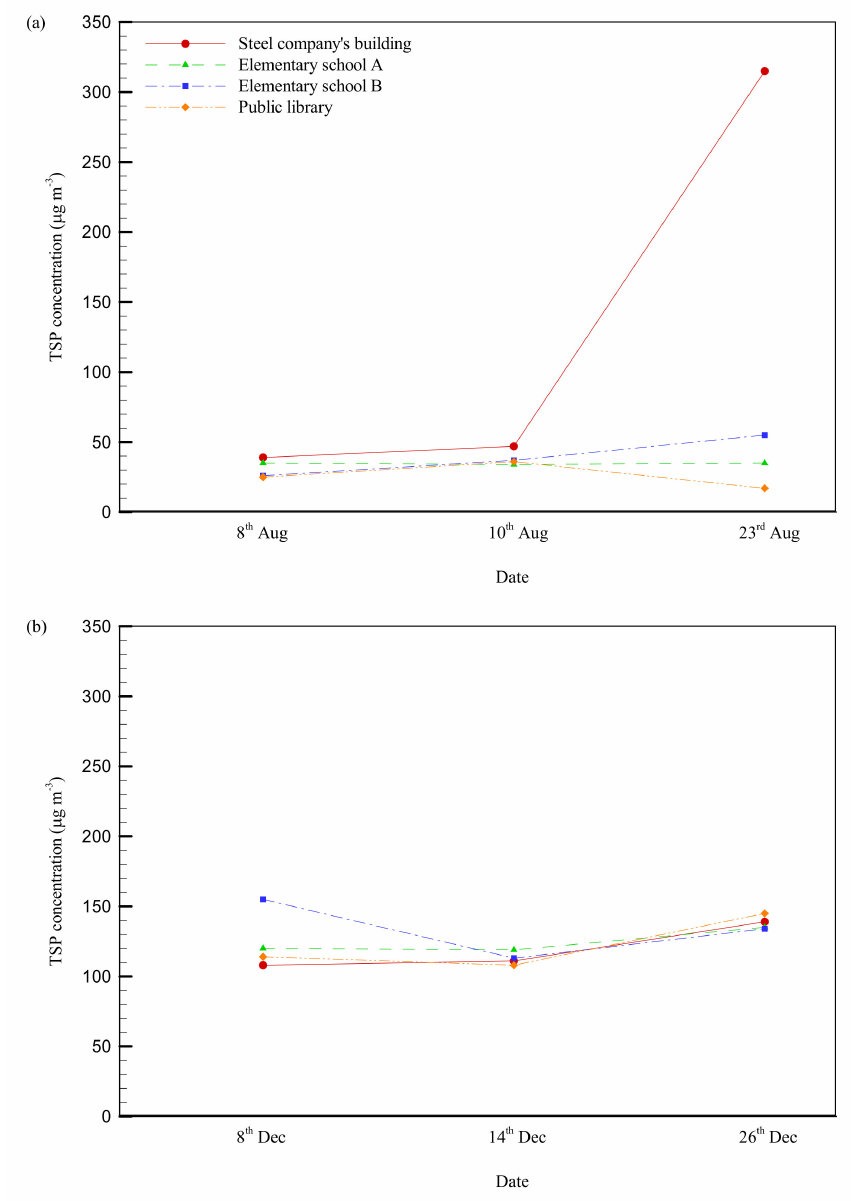
Figure 2. The concentrations of TSP in the steel company’s administration building, elementary school A, elementary school B, and the public library for ( a ) summer and ( b )